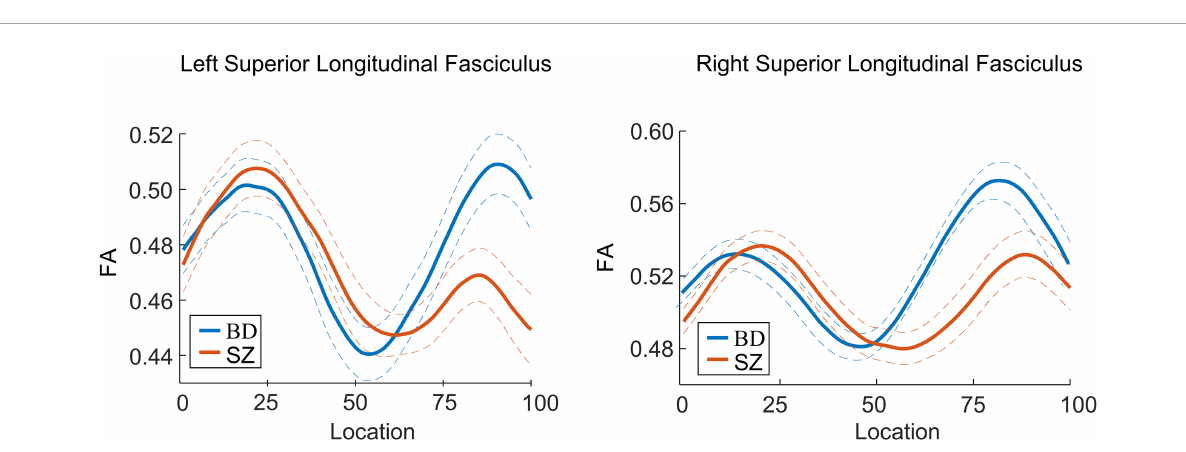
FIGURE3 Curve-trajectory plots represent the mean fractional anisotropy (FA) along the left and right superior longitudinal fasciculus in schizophrenia (SZ) vs. bipolar disorder